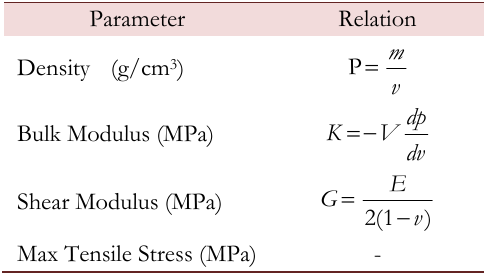
Table 2: Parameters of the crushable foam